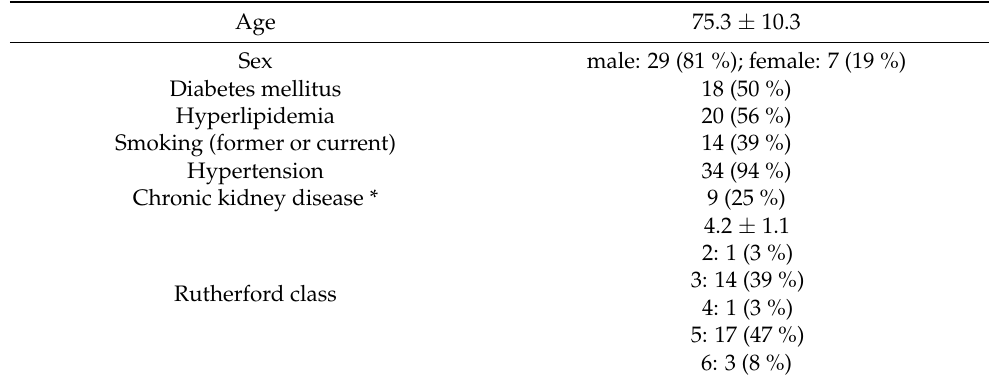
Table 1. Patient characteristics (n = 36).